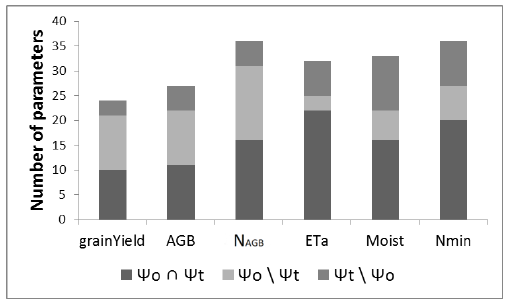
Figure 3. Numbers of relevant parameters identified by the original and extended Morris methods using τ o = 0.2 and τ t = 0.8, respectively. Ψ o ∩ Ψ t denotes the model parameters that exist in both sets. Ψ o \ Ψ t denotes the model parameters that are included in Ψ o , but not in Ψ t . Ψ t \ Ψ o denotes the parameters that are included in Ψ t , but not in Ψ o